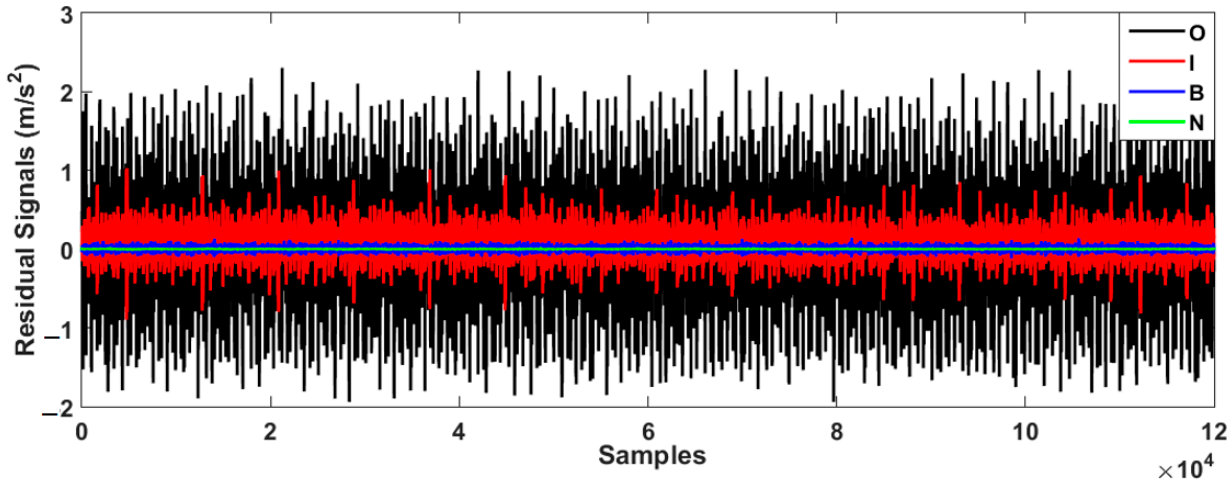
Figure 8. Bearing’s residual signals using the FVSF approach.